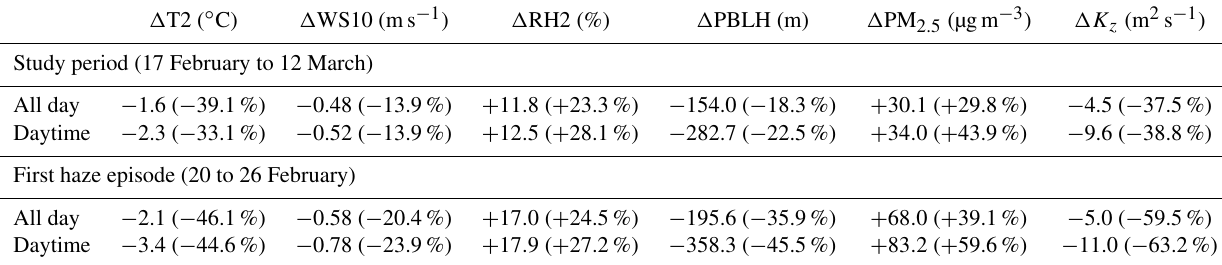
Table 6. Same as Table 5 but for